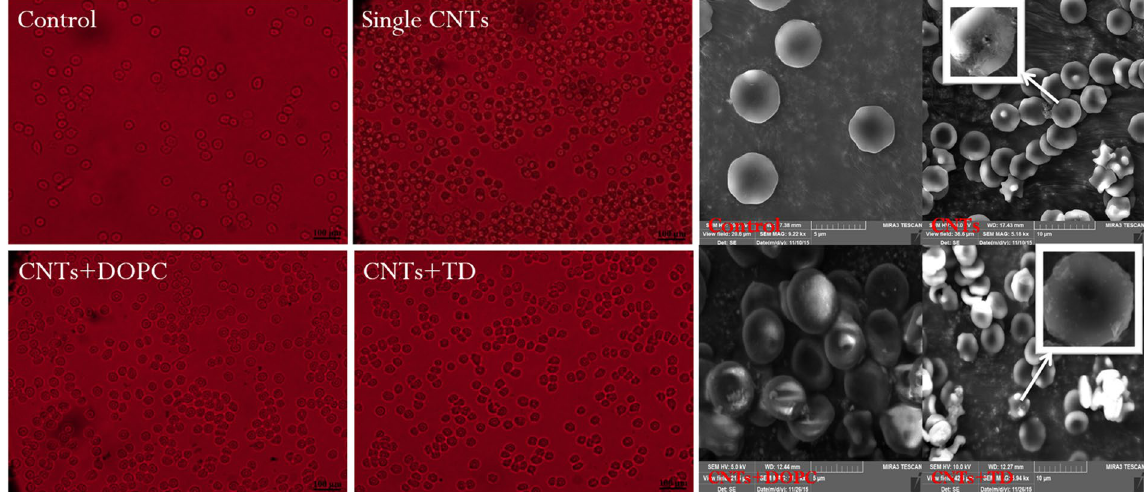
Figure 9. The cell morphology of erythrocytes under optical microscope (100 × , scale bar is100 μ m) and SEM (5–10 μ m) after exposure saline solution, oMWCNTs, oMWCNTs + DOPC and oMWCNTs + TD to erythrocytes,